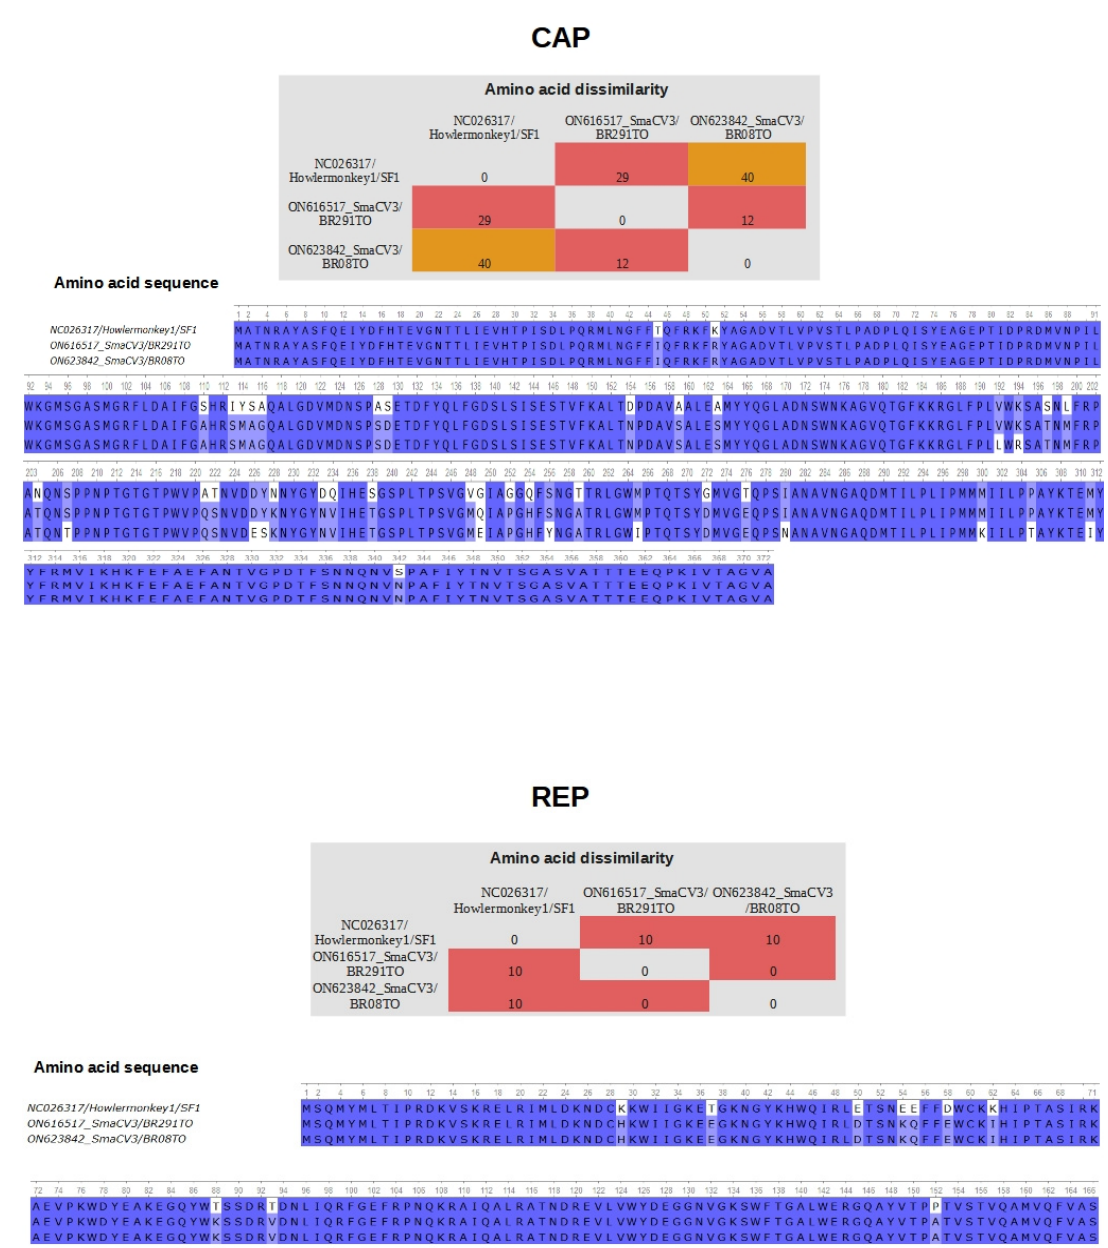
Figure 2. Amino acid composition of CAP and REP. Comparison of the predicted CAP and REP pro- teins between sequences generated in this study (SmaCV3BR08 and SmaCV3BR291) and the Howler monkey-associated porprismacovirus 1 (NC_026317). Upper panels show a matrix indicating number of distinct acid acids and the sequence of residues in the homolog region of the predicted CAP protein. The lower panels show the differences in amino acid composition and the sequences of predicted REP protein in Howler monkey-associated porprismacovirus, SmaCV3BR08 and